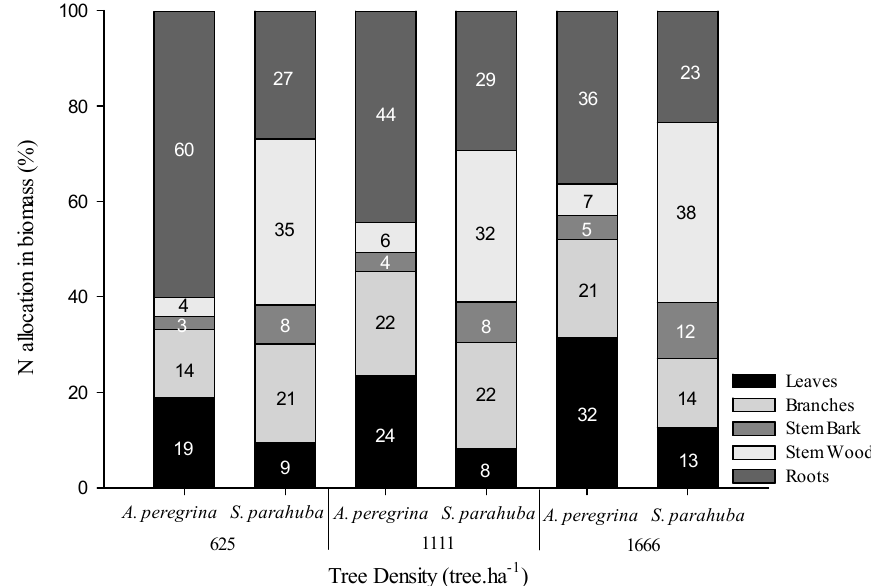
Figure 1. N pools in the leaves, branches, bark, and wood of A. peregrina and S. parahyba under different stand densities.